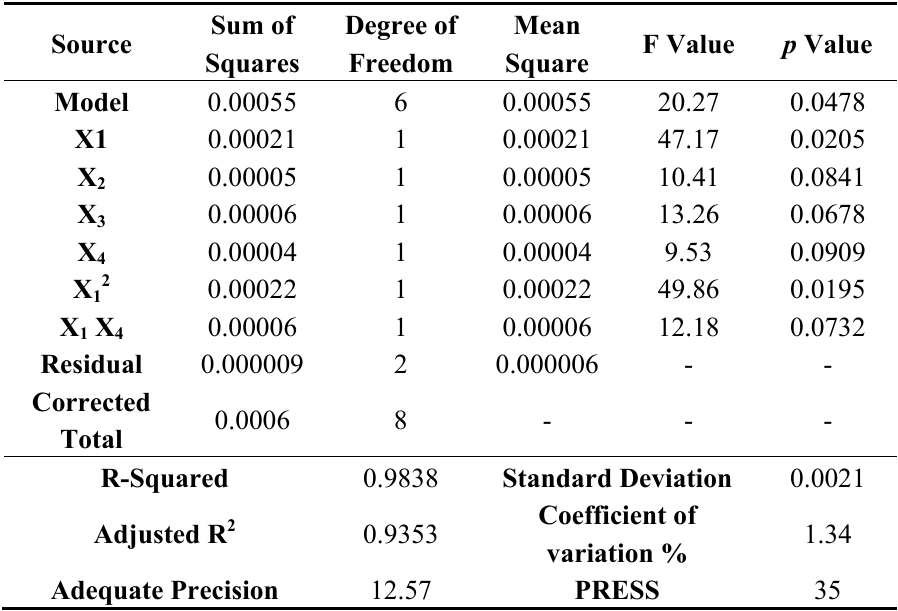
nanocrystalline deposition 2